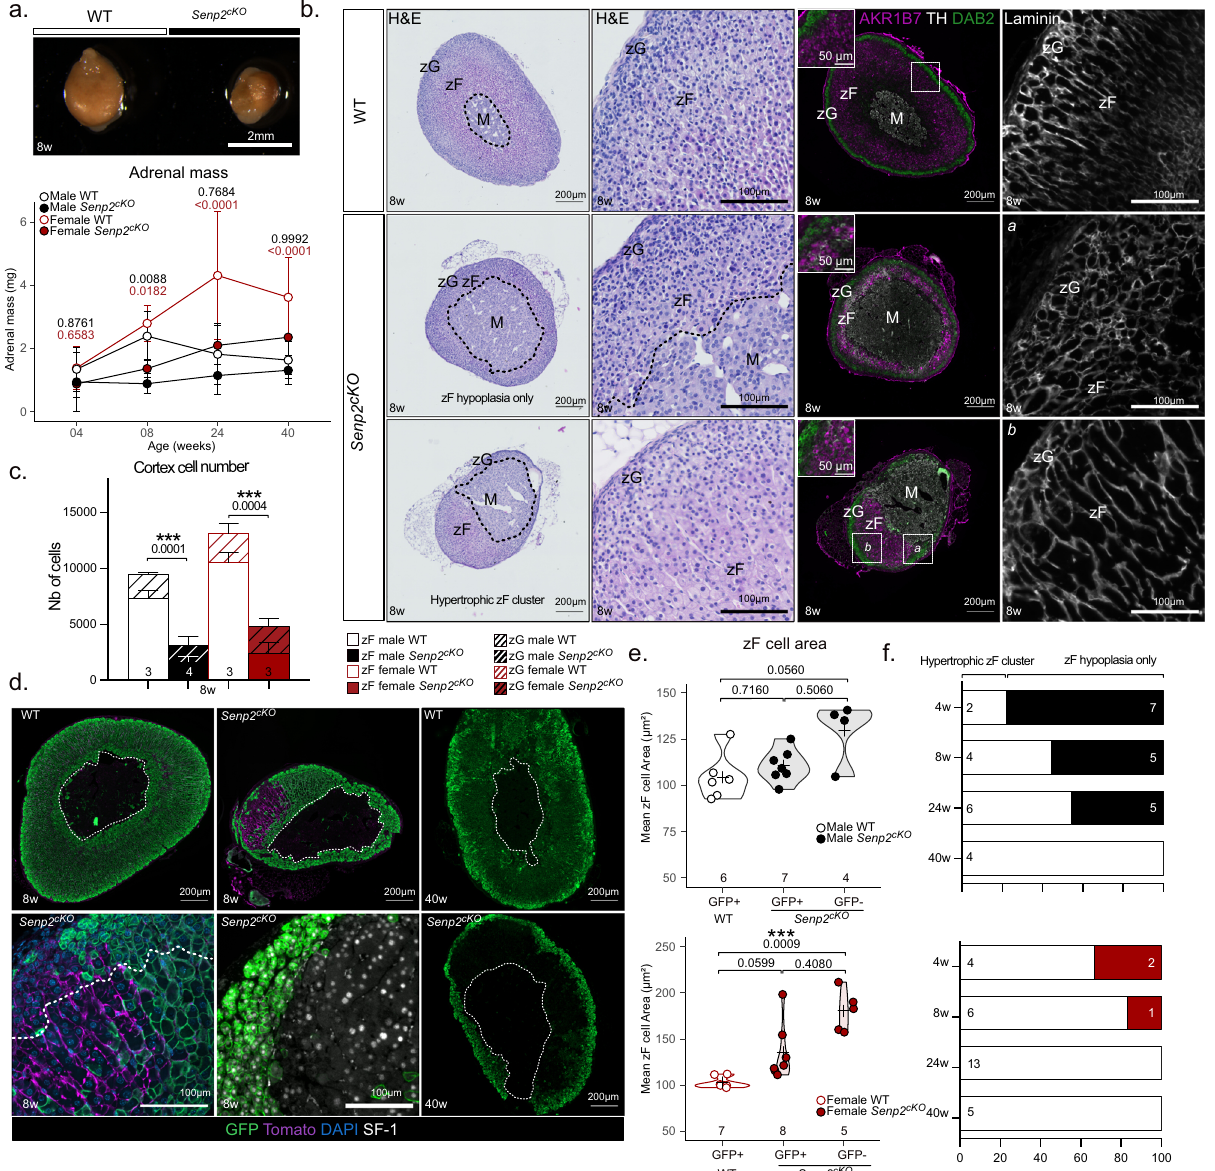
Fig. 1 | Deletion of the deSUMOylase Senp2 in embryonic steroidogenic cells induces adrenal dysplasia and zF hypoplasia in adult mice. a Top: Representa- tive picture of an 8-week-old WT (left) and a Senp2 cKO (right) adrenal. Bottom: Absolute adrenal mass follow-up ofmale( n =45,23,15and 32adrenals for WT and 37, 9, 14 and 15 for Senp2 cKO ) and female ( n =40, 28, 13 and 44 adrenals for WT and 34,7,7and27for Senp2 cKO )miceWTand Senp2 cKO (mean)from4to40weeksofage. P values represent the difference between genotypes within the same age and sex group. Data are presented as mean values+/ − SD. b Morphological analysis of the phenotypes on 8-week-old males ’ adrenals. Left: H&E staining of WT or Senp2 cKO adrenals with or without dysplasia. Centre: Coimmuno fl uorescence labelling of AKR1B7 (purple), TH/Tyrosine Hydroxylase (white) and DAB2/Disabled2 (green) in WT and Senp2 cKO adrenals. Right: Immuno fl uorescence analysis of laminin (white) revealingthe vascularnetworkinWTand cKOadrenals. c 2D cellnumbercounting inmaleandfemaleadrenalsat8weeksofage.( n =4adrenalsfor Senp2 cKO malesand